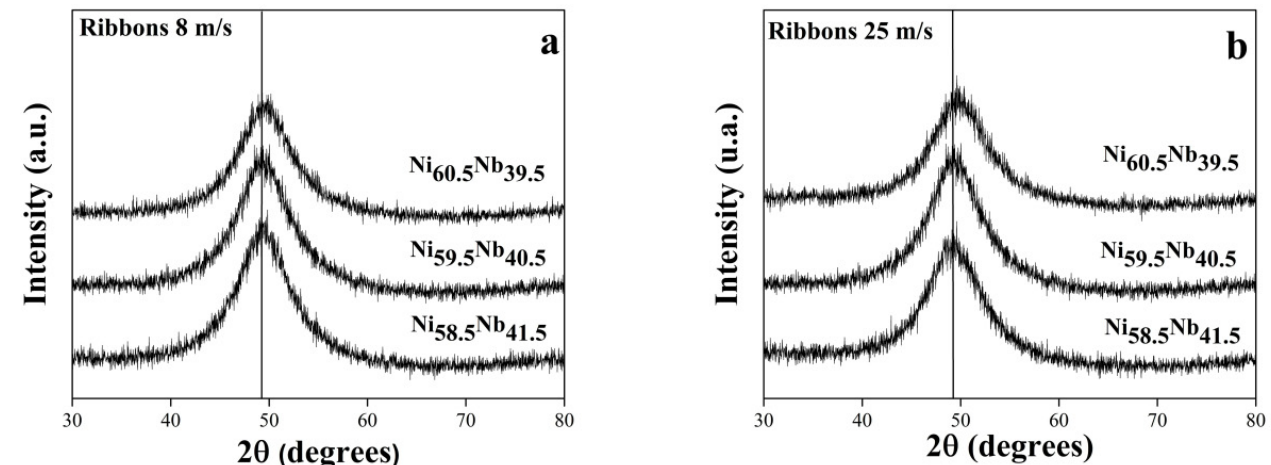
Figure 2. ( a , b ) . XRD patterns of ribbons cast at 8 and 25 m/s for the Ni 58.5 Nb 41.5 , Ni 59.5 Nb 40.5 and Ni 60.5 Nb 39.5 alloys.